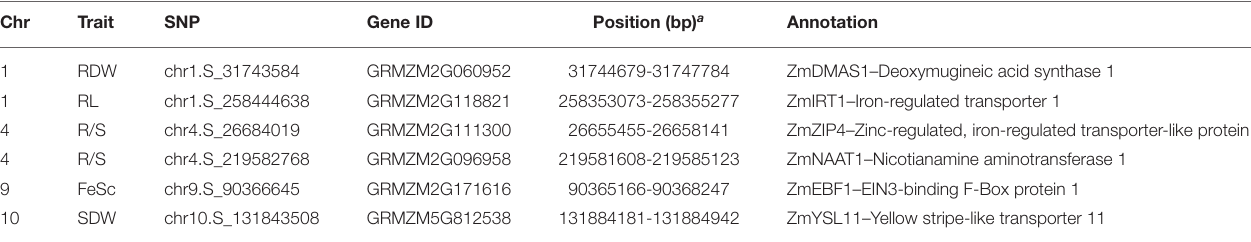
TABLE 1 | Candidate genes associated with Fe-deficiency tolerance identified by GWAS in